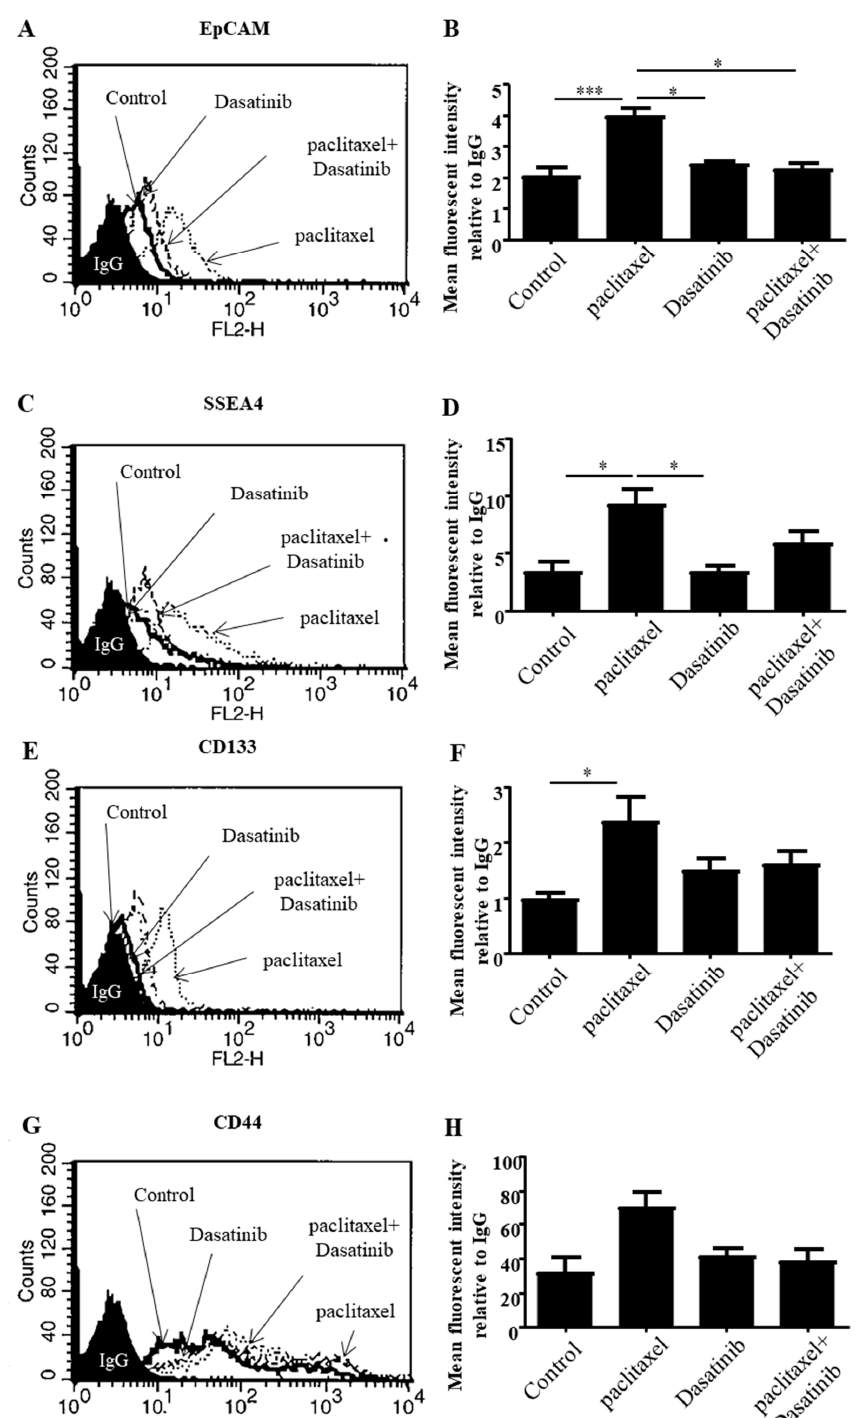
Figure 4. CSC-like marker expression is reduced with Dasatinib treatment. Surface expression of ( A , B ) EpCAM, ( C , D ) SSEA-4, ( E , F ) CD133 and ( G , H ) CD44 in ovarian cancer HEY cells, following a